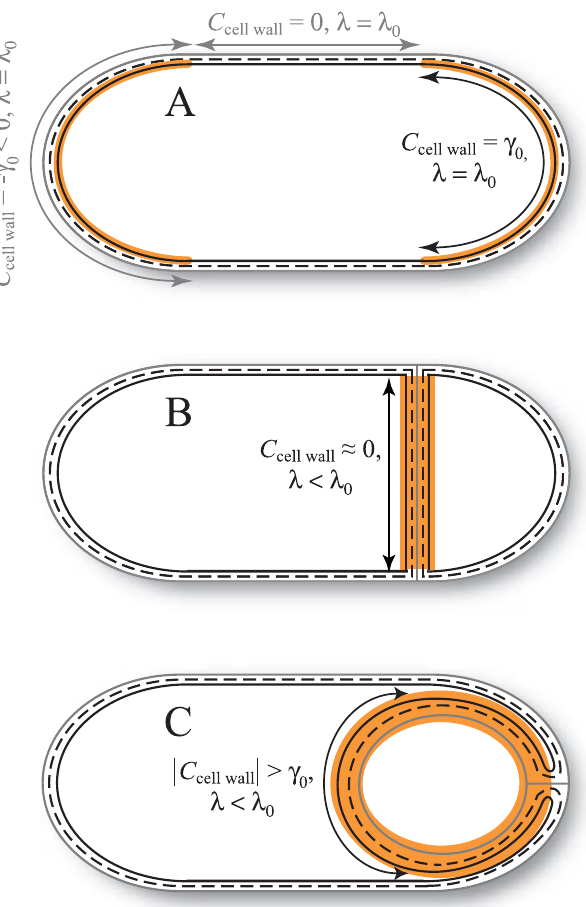
Figure 6. Competition between Curvature and Osmotic Localization of Lipid Clusters during Sporulation and Cell Division (A) During exponential growth, high-intrinsic-curvature lipid clusters localize to the poles of the inner leaflet (solid black curve), driven by differences in membrane curvature. All curvatures are shown relative to curvature in the cylindrical region of the cell. The cell-wall curvature experienced by the outer leaflet (solid gray curve) is opposite in sign to the intrinsic lipid curvature. Orange regions denote cardiolipin local- ization. (B) A lower osmotic-pressure differential across the septal/forespore- engulfing membrane corresponds to a reduced value of the pinning modulus k and induces relocalization of the lipid clusters to the septal membrane (see Figure 5). (C) As the spore is engulfed, the clusters can migrate along the continuous leaflet consisting of the inner leaflet of the mother cell and the outer leaflet of the forespore-engulfing membrane to localize around the spore due to low osmotic-pressure differential.